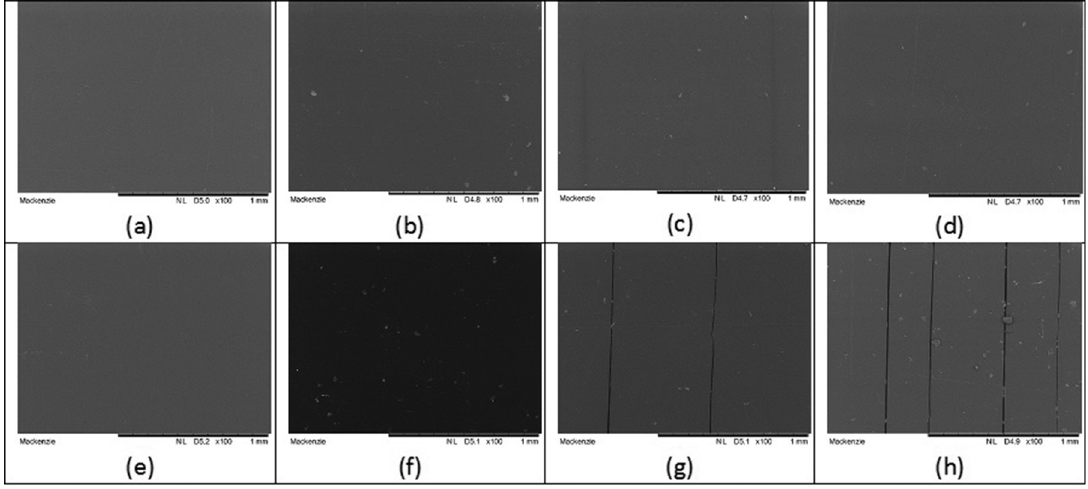
non-exposed (a) and exposed for 3 (b), 6 (c) and 12 weeks (d); and PHB 1